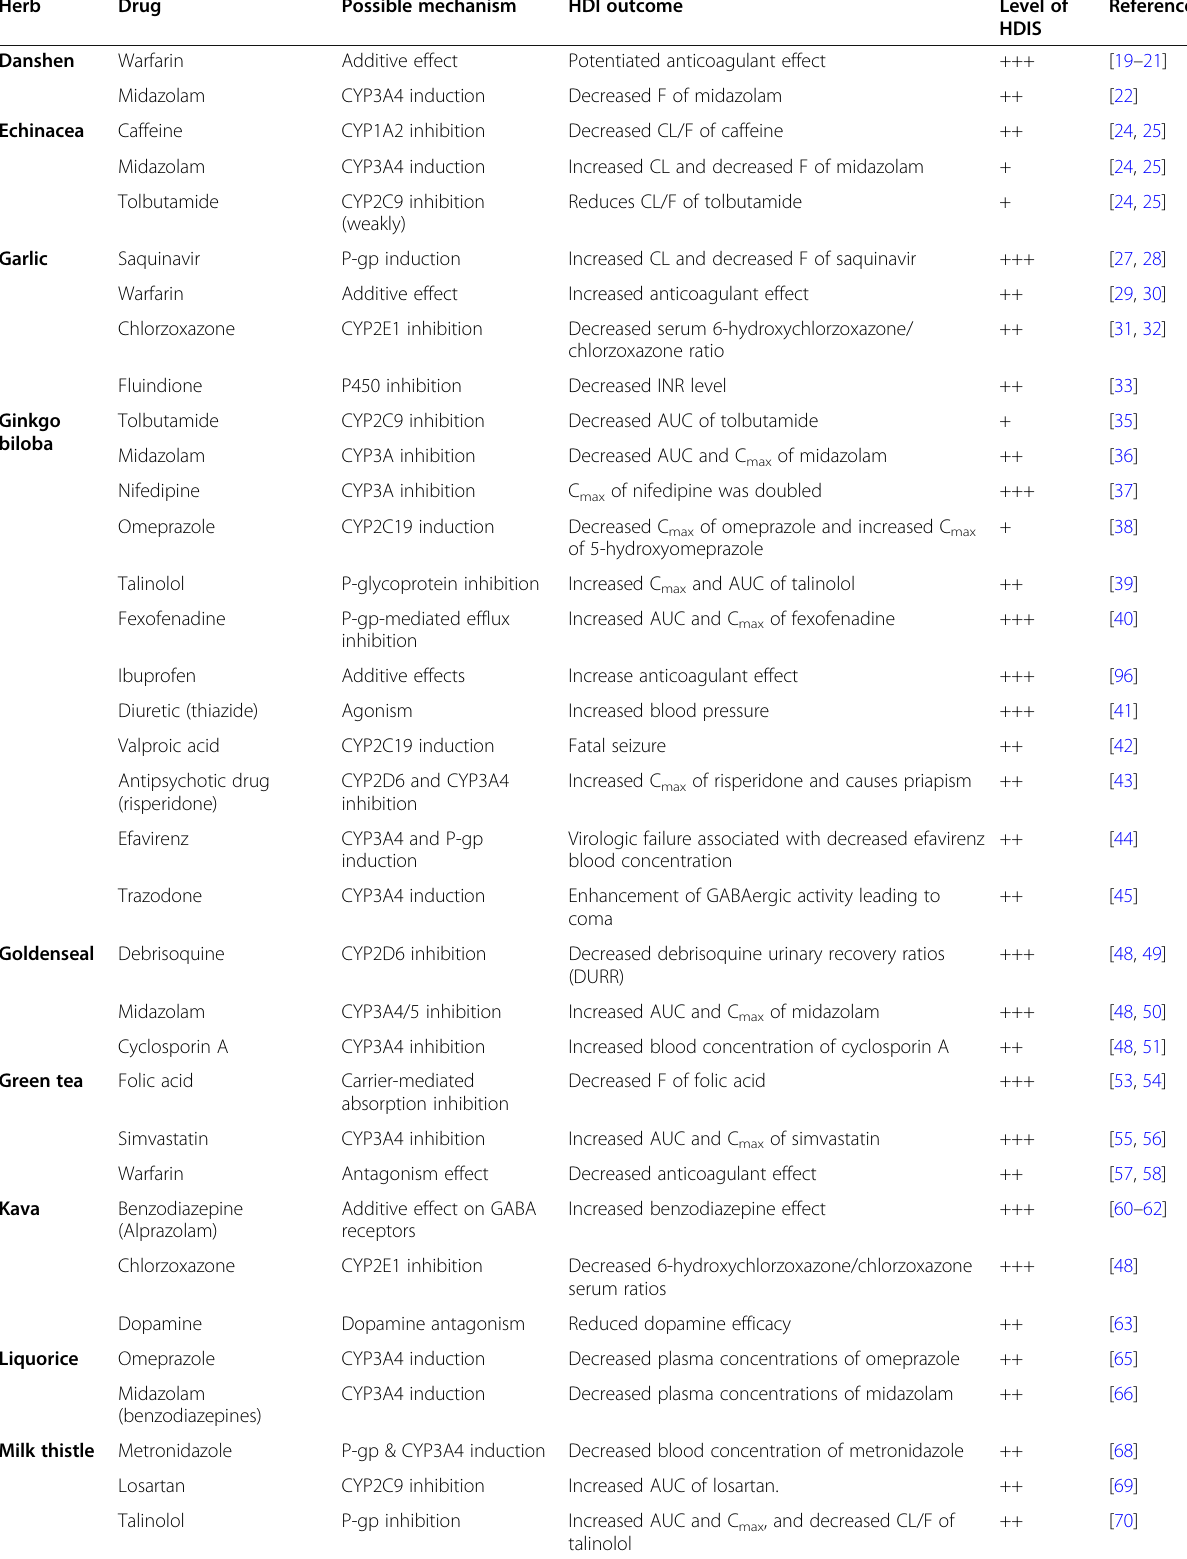
Table 1 Herb-drug interactions (HDIs) of some herbs with possible mechanism, outcome and level of HDIs